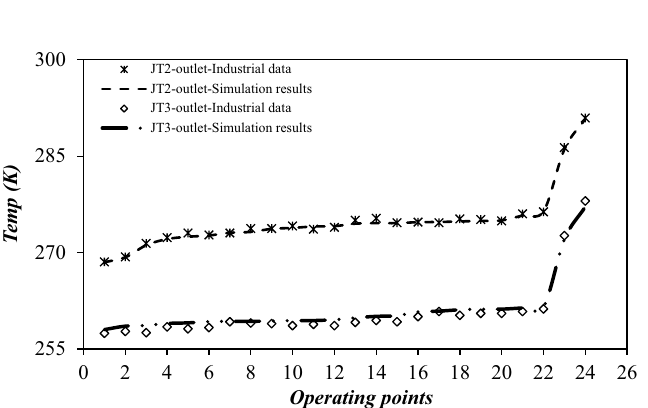
Figure 2. Comparison between simulation result and gas plant data for various operating